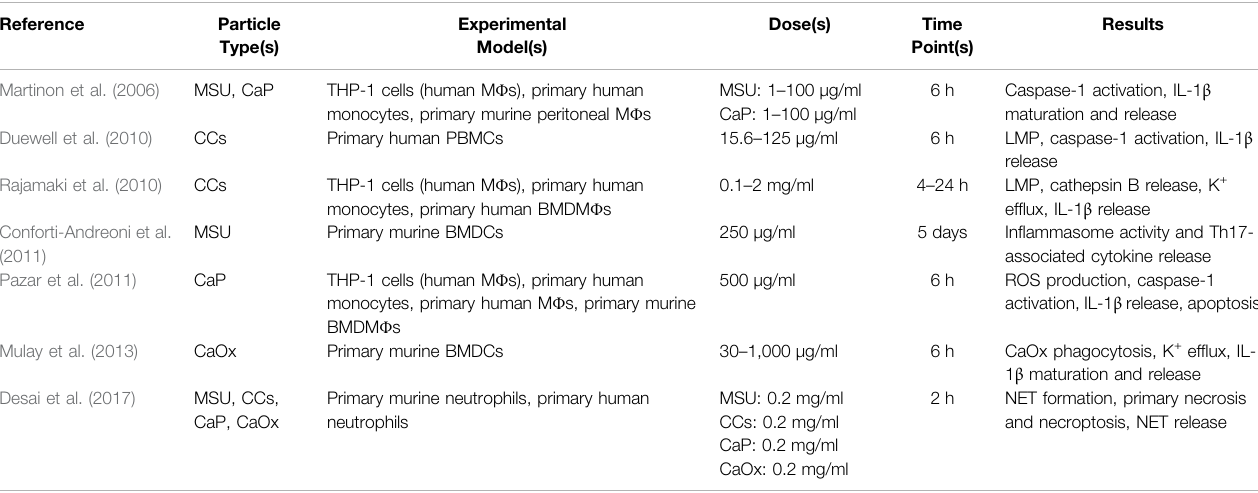
TABLE 3 | Examples of studies demonstrating toxic responses of endogenous particles.